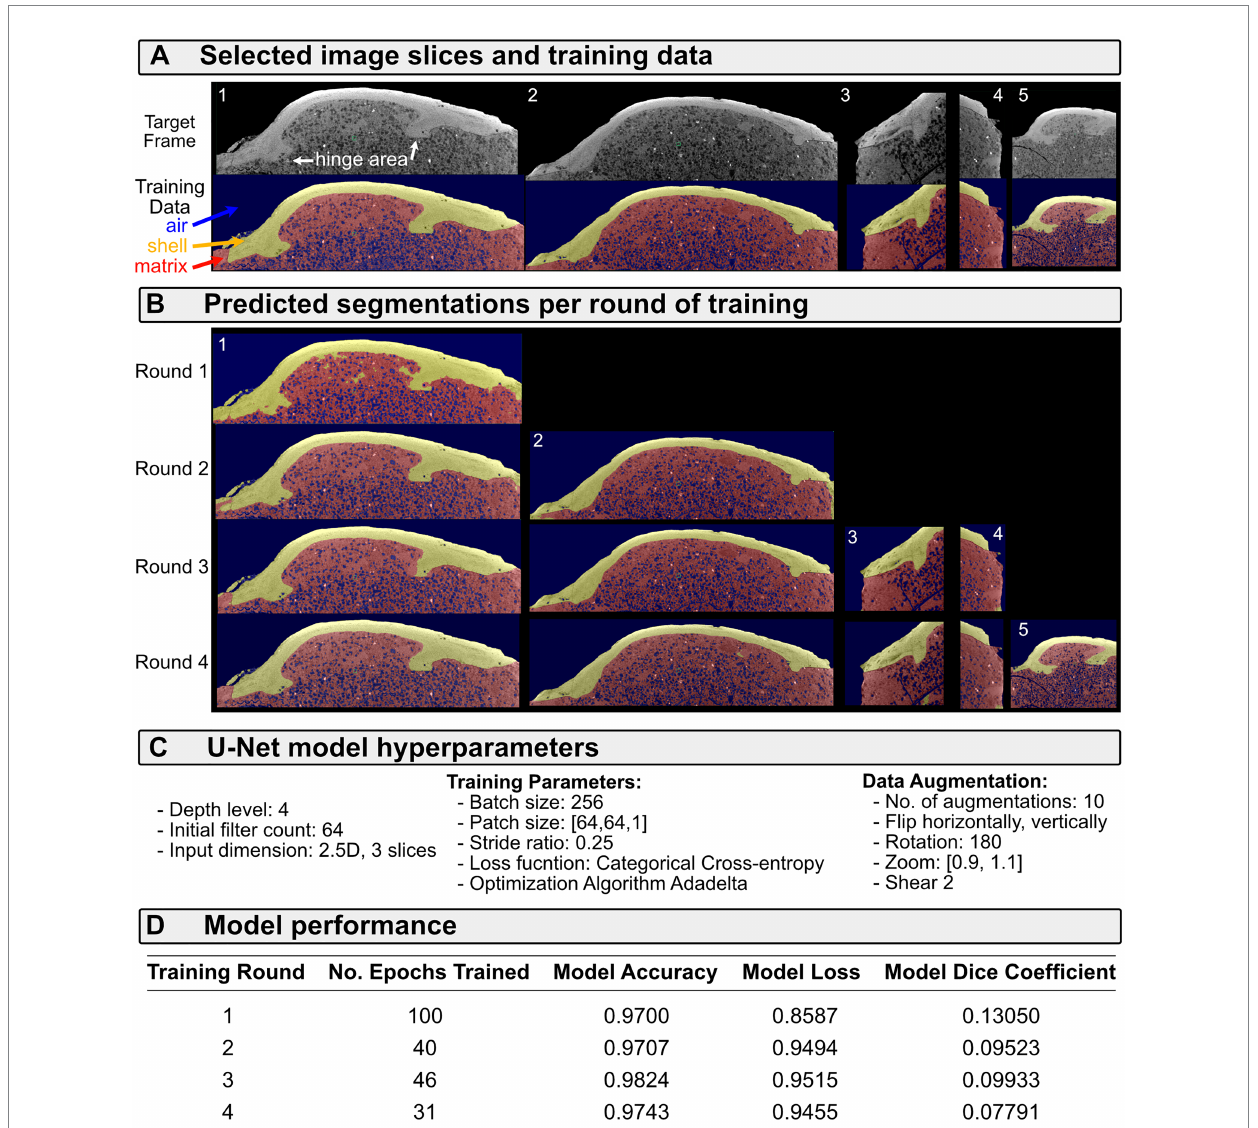
FIGURE 3 Segmentation of shell from matrix using deep learning for specimen USNM PAL 20943, “Lucina” parvilineata . (A) Selected image slices cropped to training frames in the top row, with frame number in white text. Bottom row shows ground-truth labeled training data. (B) Predicted segmentation for image slices per round of model training, i.e., only frame 1 was trained in round 1, but frames 1 and 2 were used to train round 2, so both have predicted segmentations for this round. Both frames 3 and 4 were included in round 3 of training. Frame 5 was only included in round 4. (C) Hyperparameters of the U-Net model. (D) Model performance statistics for each round of